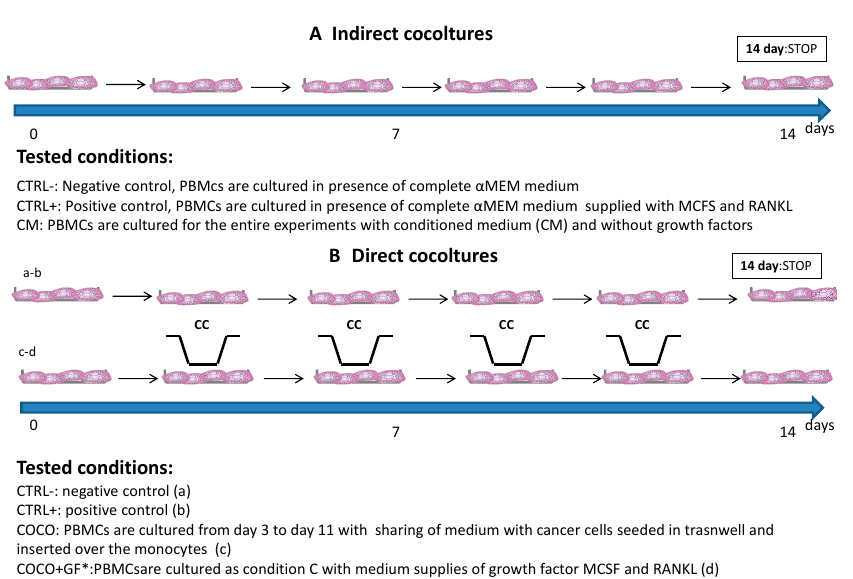
SCP2 culture medium (CM) and with 20 ng/mL RANKL and MCSF (CTRL+, obtained supplying cells with DM).